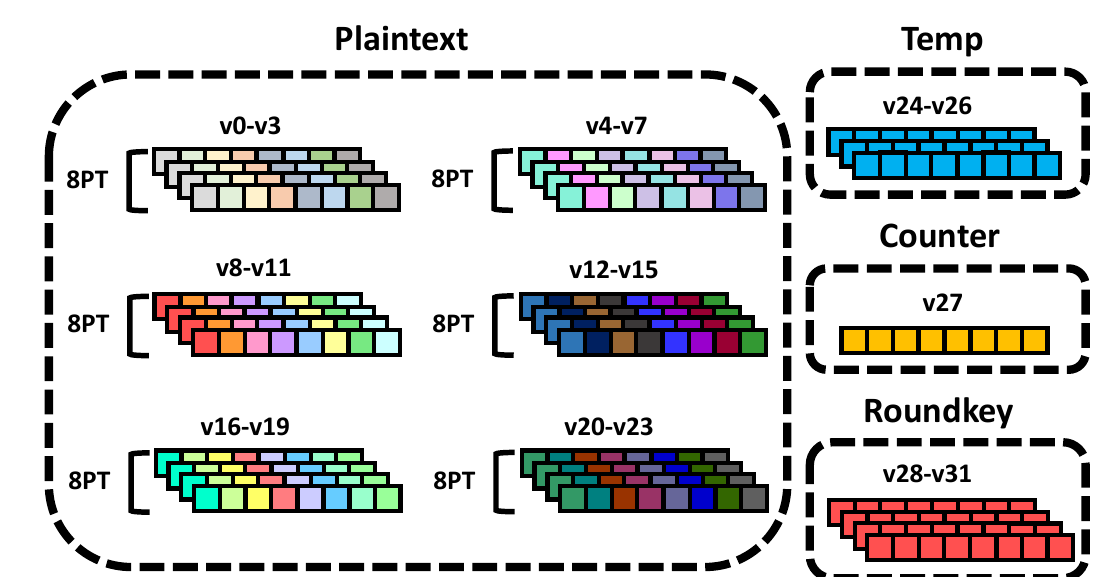
Figure 10. Proposed vector register scheduling for revised